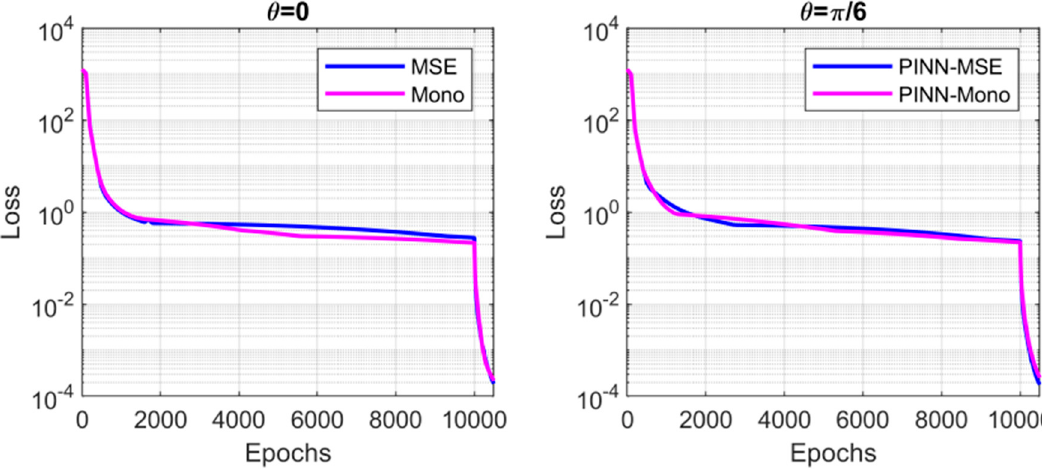
Figure 4. Loss history of PINN for case 1. Left: 𝜃 = 0 ; right: 𝜃 = 𝜋/6 .